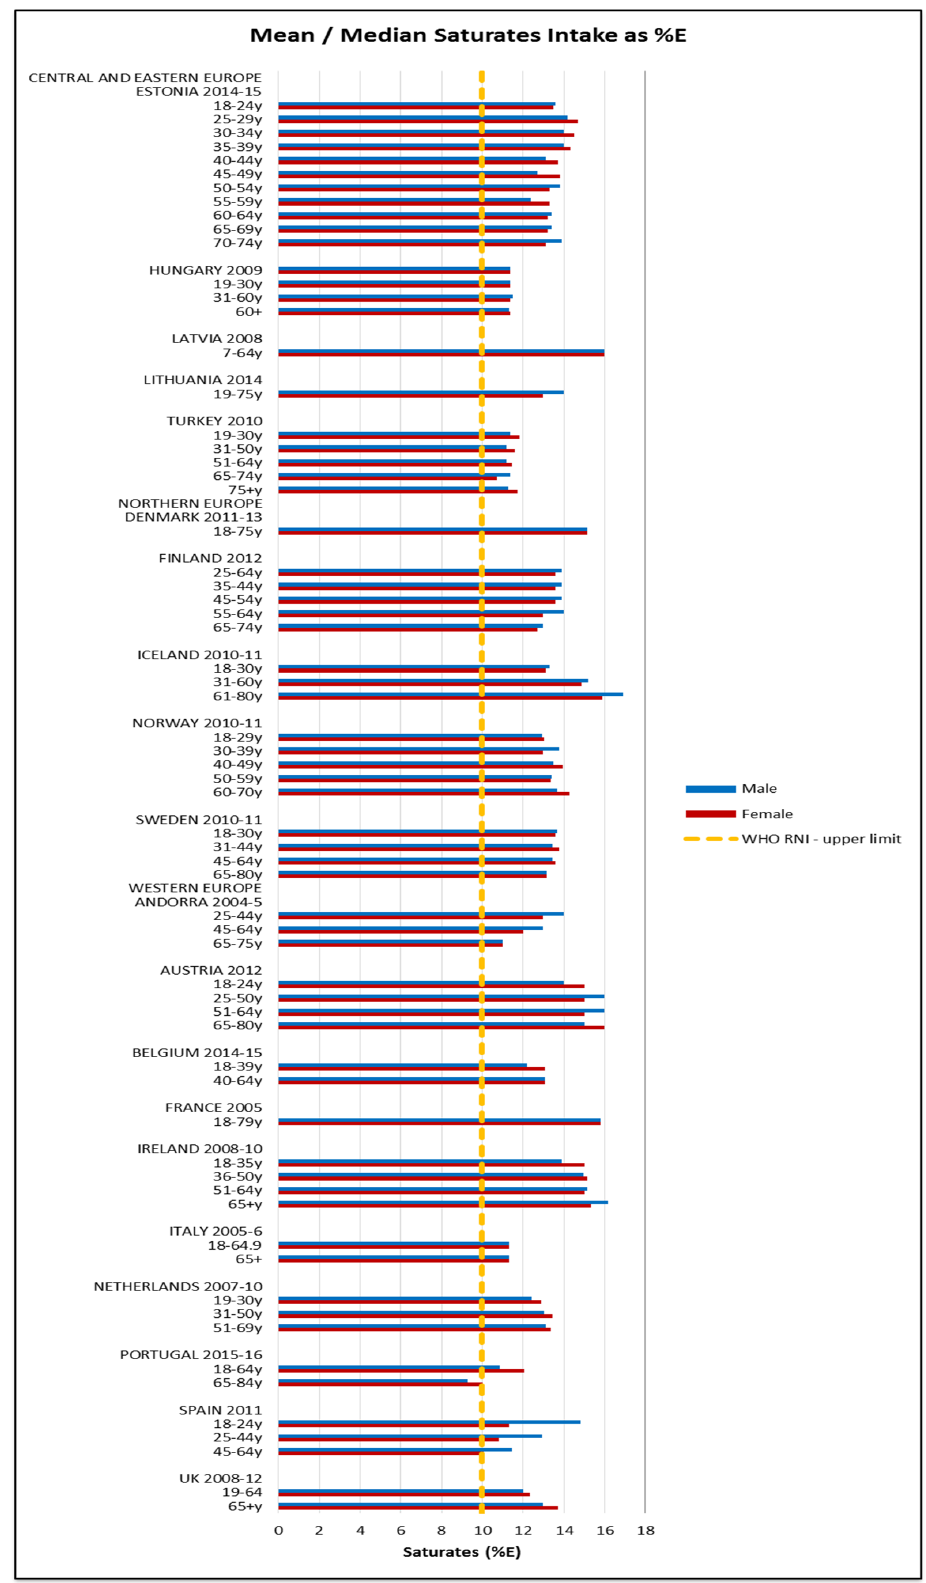
Figure 8. Mean/median* adult saturates intake (g/day) (excluding supplements). * Figures for Spain are based on median rather than mean values.